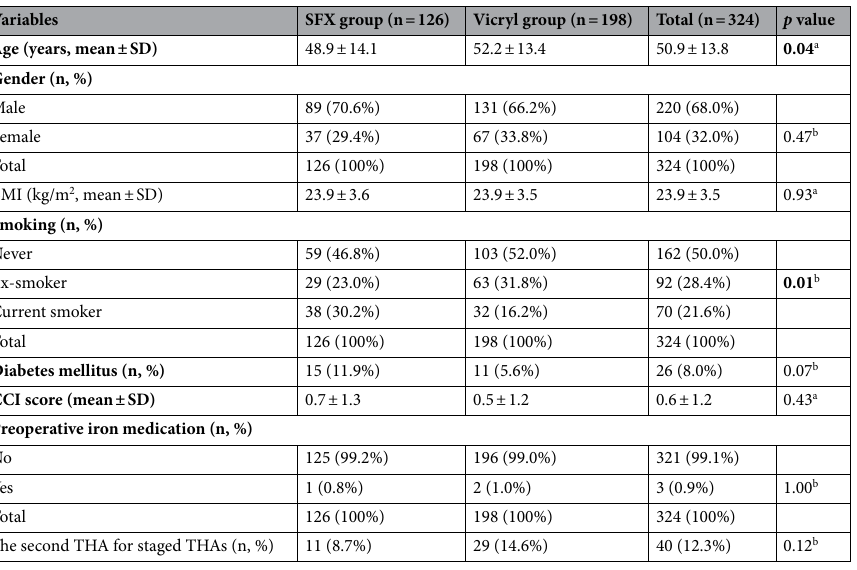
Table 1. Patient demographics. Significant values are in bold. SD, Standard deviation; BMI, body mass index; CCI, Charlson Comorbidity Index. a By independent t-test. b By chi-square